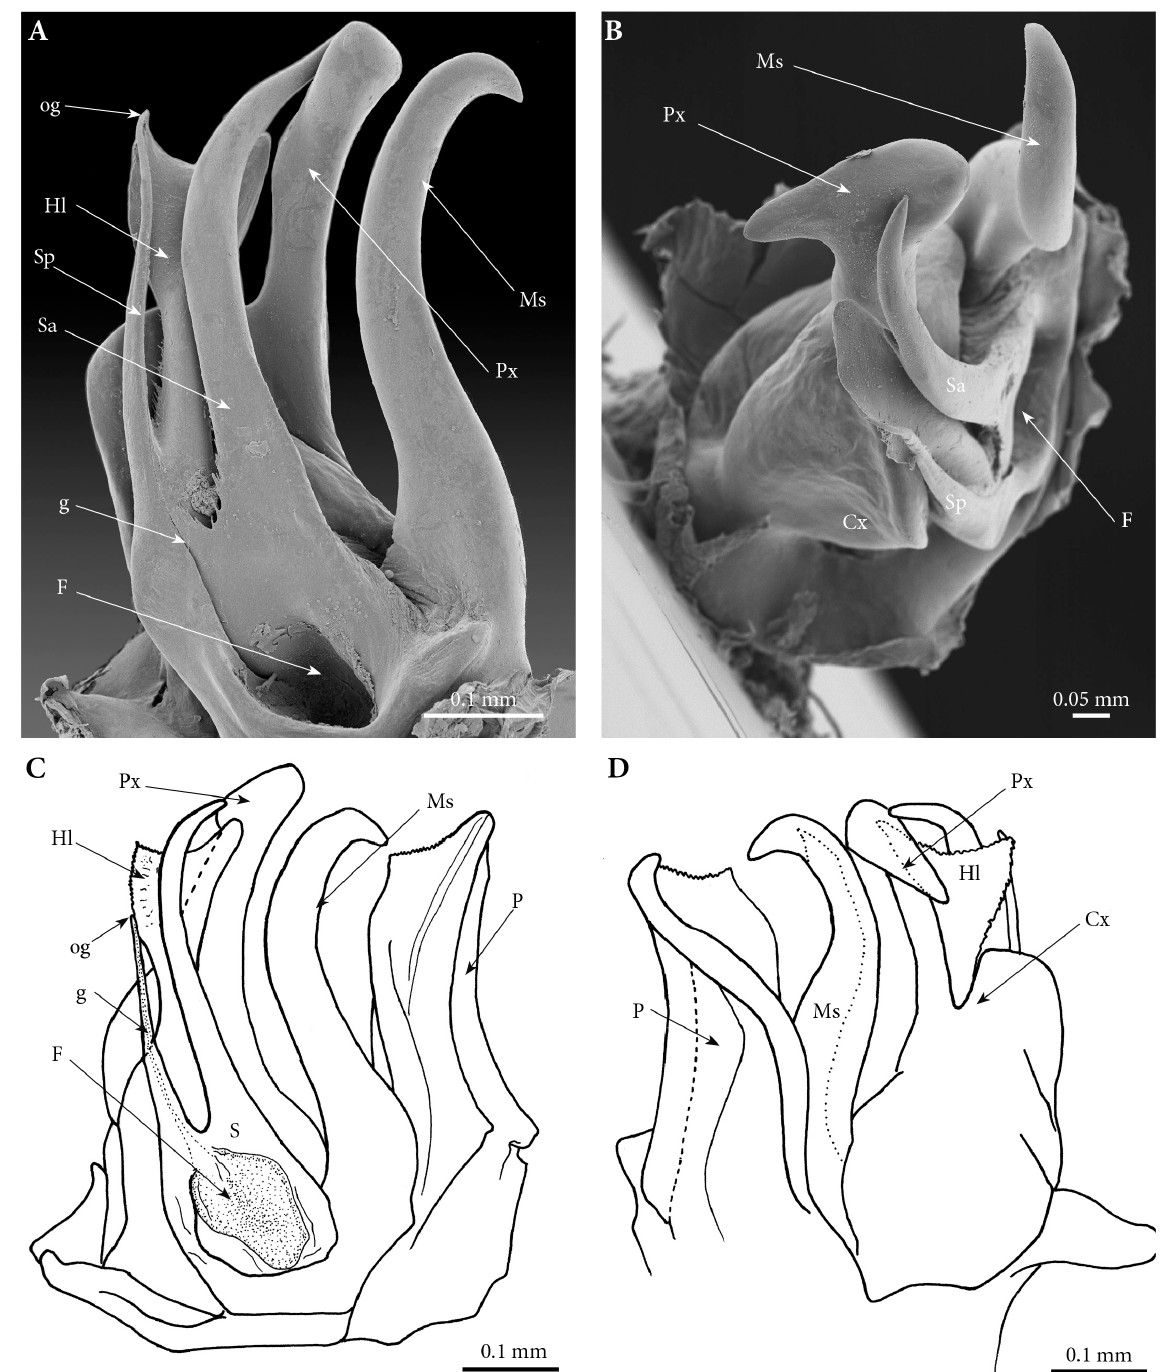
Fig. 14. Ommatoiulus litoralis sp. nov. A–B . Paratype, ♂ from Aljezur, right gonopod. A . mesal view. B . Disto-mesal view. C–D . Paratype, ♂ from Algarve, right gonopods. C . mesal view. D . lateral